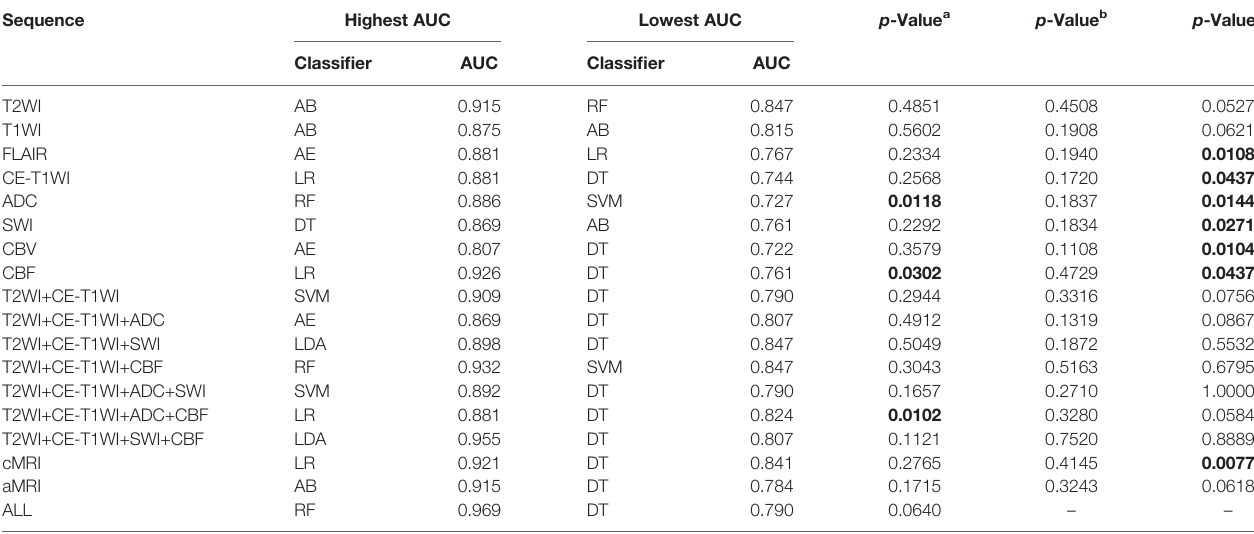
TABLE 3 | Results of DeLong ’ s test of the best models with different classi fi ers. Sequence